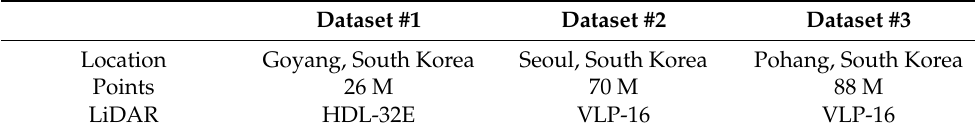
Table 1. Datasets of the case study.